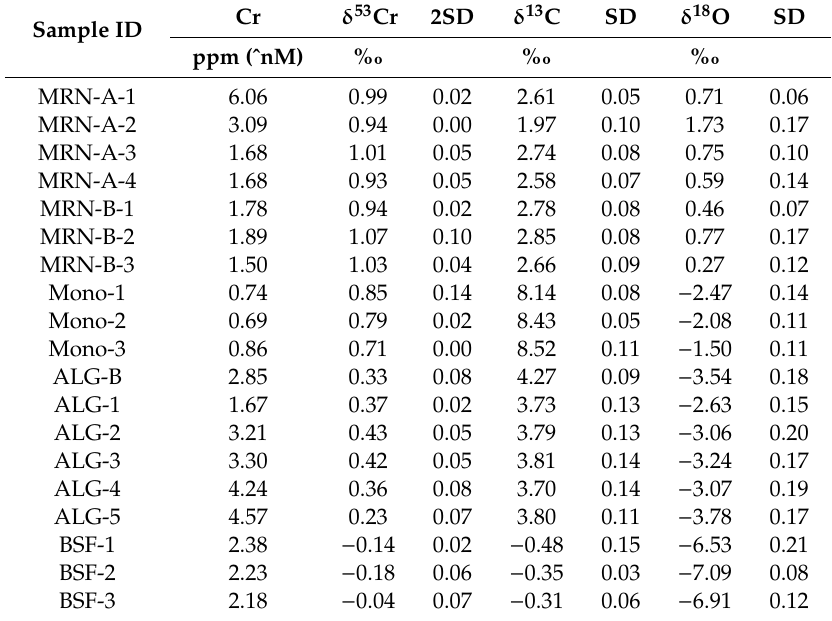
Table 2. Chromium concentrations (ppm for solids, in nM for liquids) and stable Cr, C, and O isotope